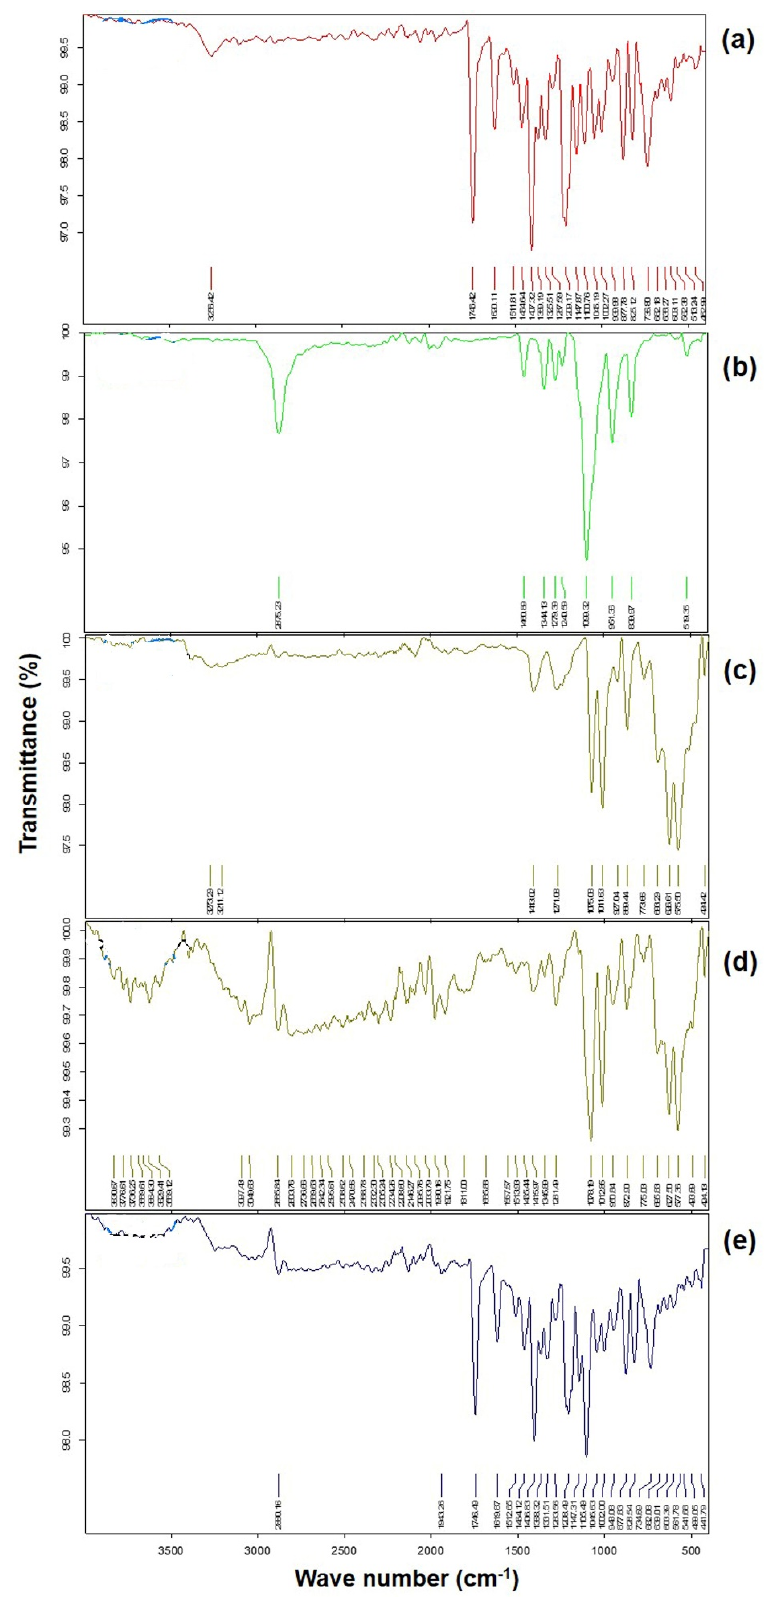
Figure 6. FTIR − Spectra of pure TZP ( a ), P188 ( b ), mannitol ( c ), PM of TZP, P188, and mannitol ( d ) and lyophilized NC 1 ( e ).